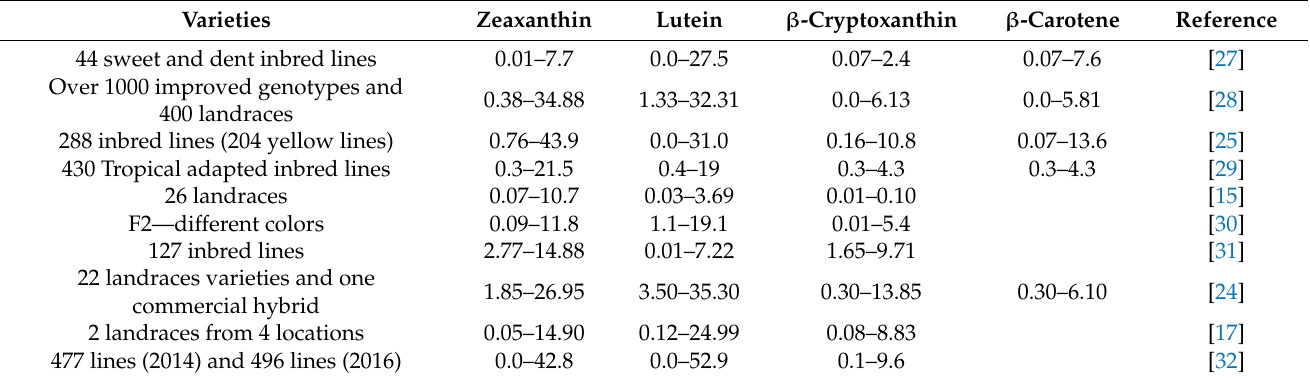
Table 1. Carotenoid content reported in studies regarding maize landraces and inbred lines ( µ